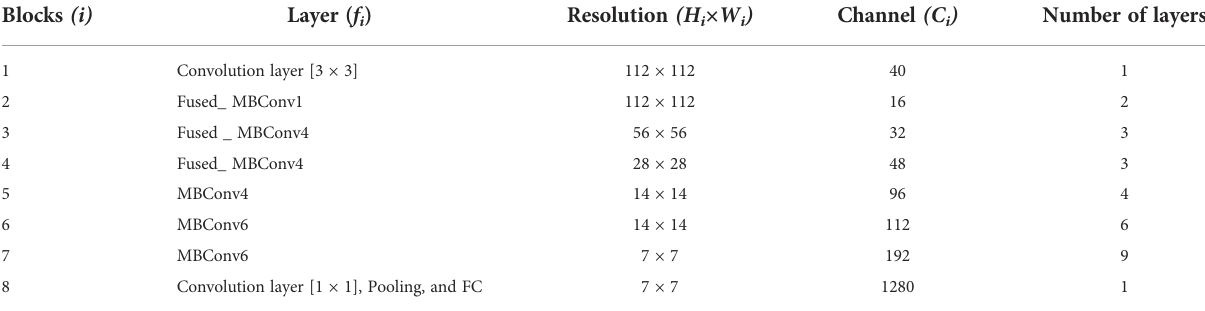
TABLE 2 Architecture of Ef fi cientnetv2 baseline network.